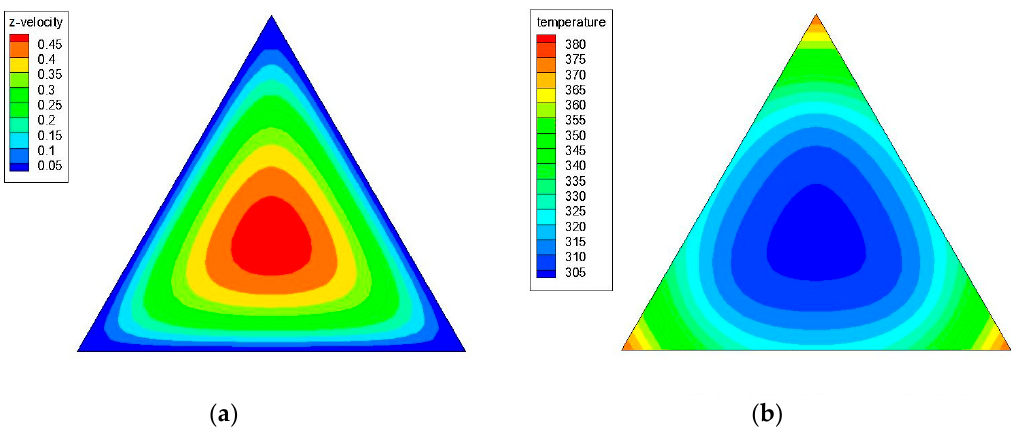
Figure 4. ( a ) Axial velocity and ( b ) temperature contours in a triangular cross-sectional duct with a hydraulic diameter ( D h ) of 4.2 mm for water at z / D h = 200 and Re = 1100.